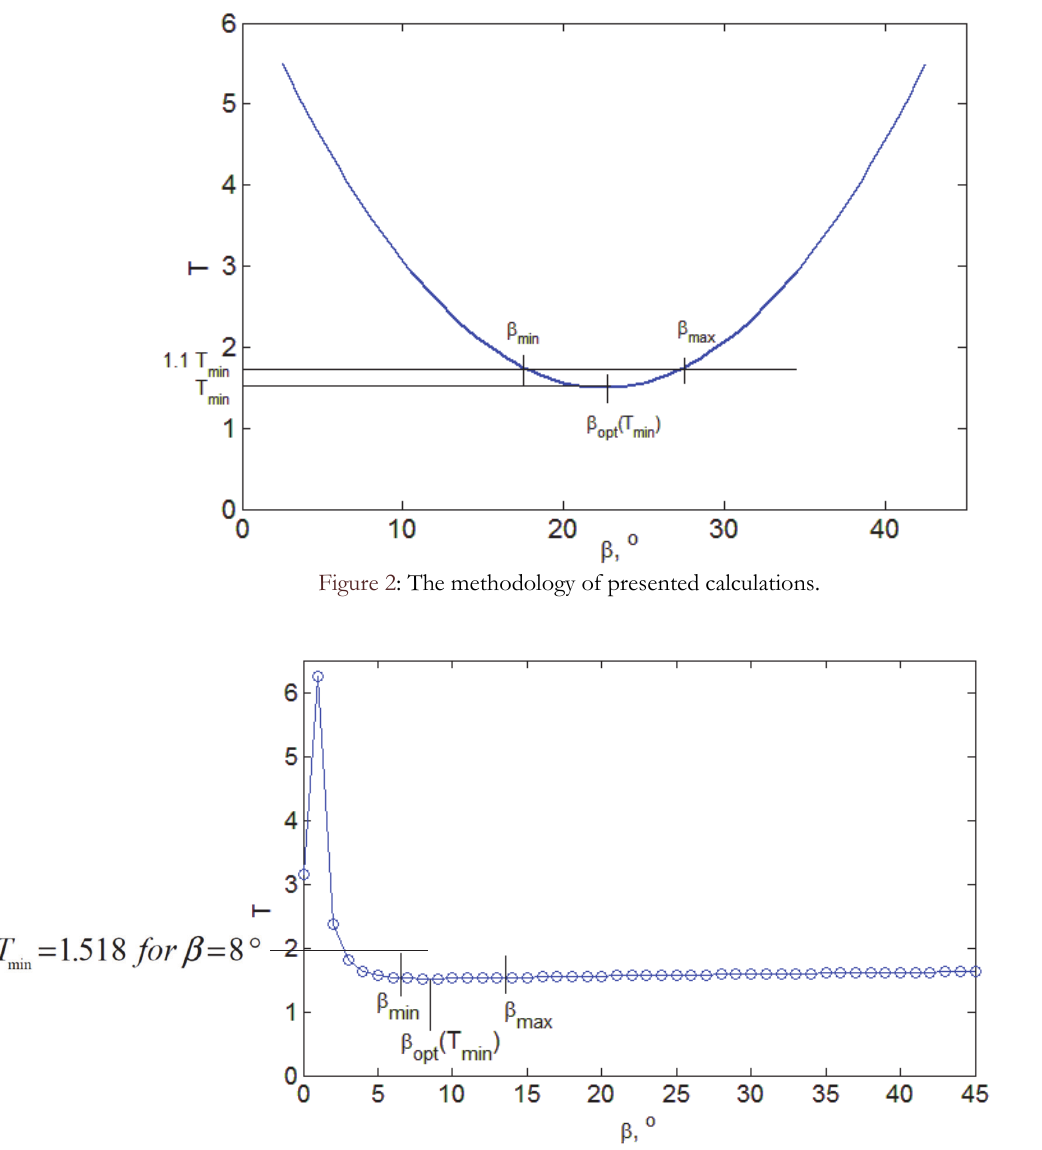
Figure 3: Relationship between scatter values T and the angle β for